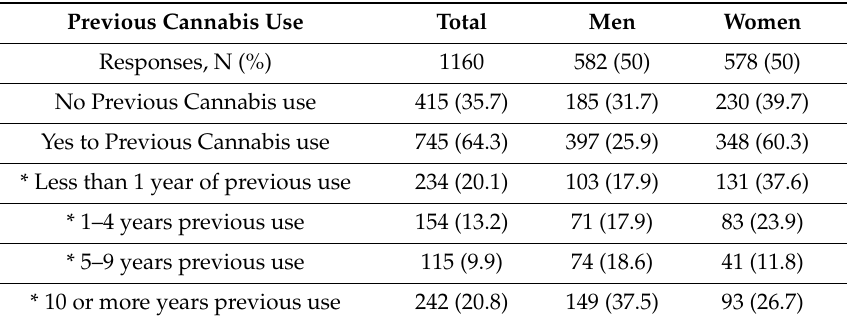
Table 2. Comparison of male and female self-reports for previous cannabis use.